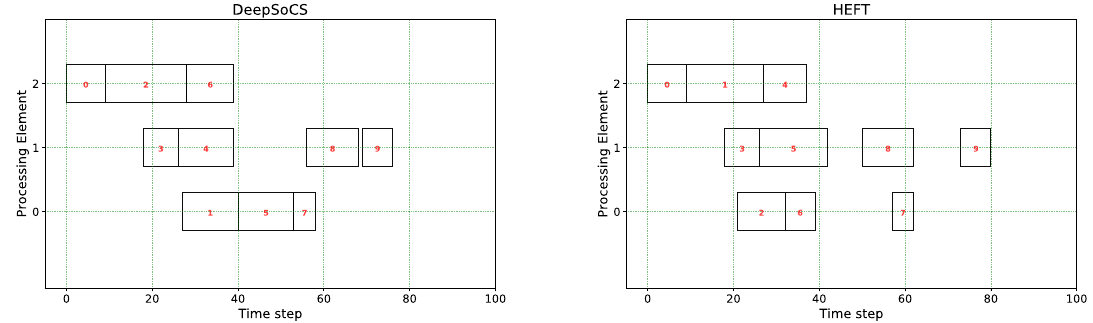
Figure 8. The Gantt charts for performing single job using DeepSoCS and HEFT algorithms are shown. A simple profile has been